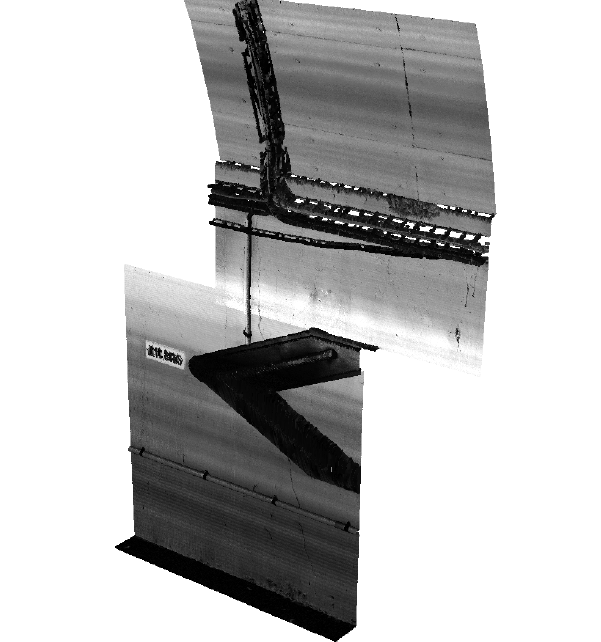
Figure 13. Local 3D model corresponding to the images in fig. 11. The points are colored using the intensity